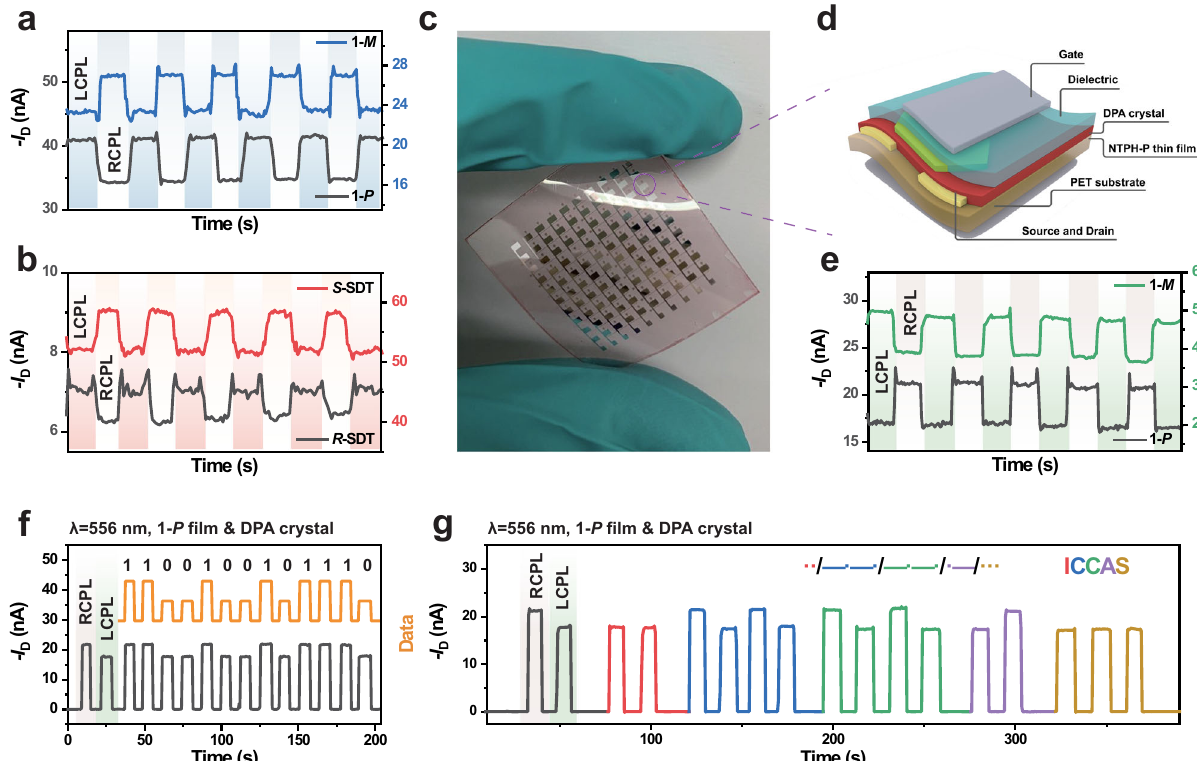
Fig. 4 Multi-wavelength circularly polarized light detection. a Real-time I D change of the detector in response to 488 nm LCPL and RCPL illumination of the NTPH-P/DPA crystal-based photodetector. The blue shading and gray shading are tested with the illumination of LCPL and RCPL, respectively. b Real- time I D change in response to the 700 nm LCPL and RCPL illumination of the SDT/DPA crystal-based photodetector. The red shading and gray shading are tested with the illumination of LCPL and RCPL, respectively. c Optical microscopy image of the fl exible device based on 1- P /DPA crystal. d Architecture of the fl exible device fabricated on PET substrates. e Real-time I D change of the detector in response to 556 nm LCPL and RCPL illumination of the fl exible photodetector based on NTPH-P/DPA crystal. The green shading and gray shading are tested with the illumination of LCPL and RCPL, respectively. f , g Information transmission of fl exible photodetector based on 1- P /DPA crystal. The green shading and gray shading are tested with the illumination of LCPL and RCPL,